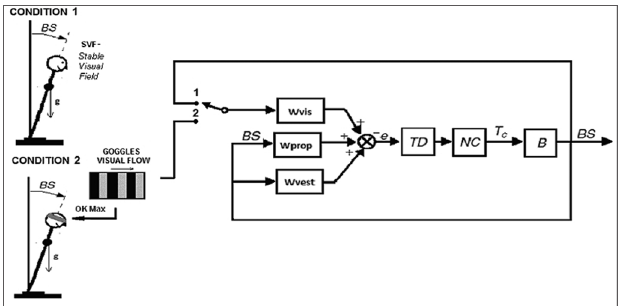
Figure 1. Model of the postural control system - (BS) Body-in-space is the angular desviation from the vertical, (B) human body as an inverted pendulum, (NC) Neuromuscular controller, (TD) Time Delay and Wvis, Wprop, Wvest weighting factors of the visual, proprioceptive and vestibular sensors